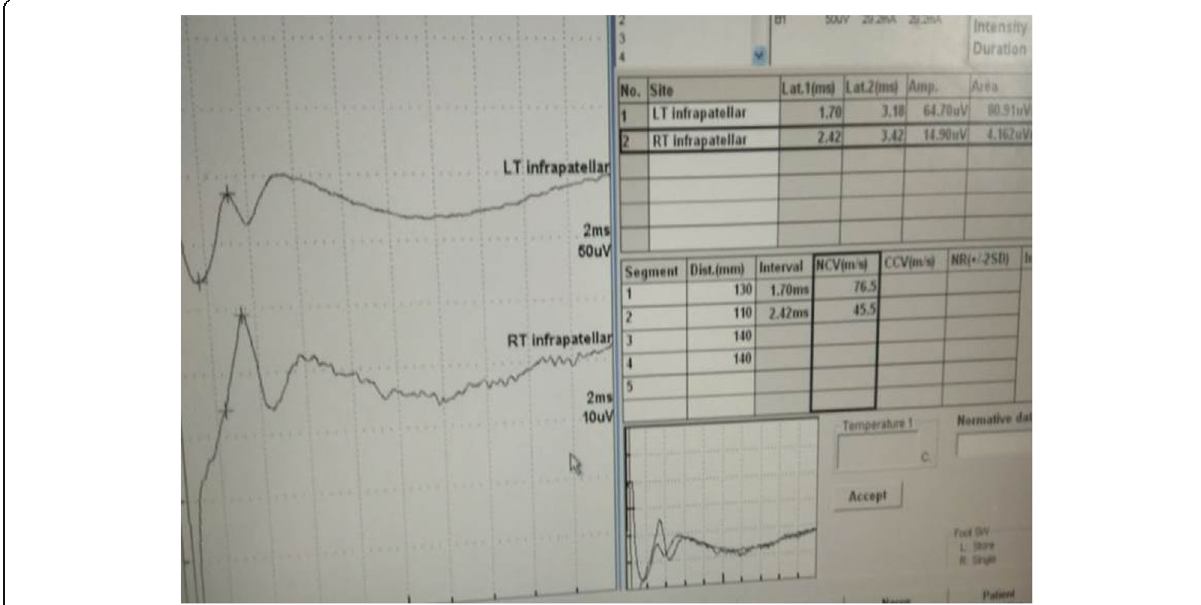
Fig. 2 Electrophysiological parameters of infrapatellar nerve including the peak sensory latency and amplitude, performed in the department of Rheumatology and Rehabilitation by assessment of the sharing rheumatologist using NIHON KOHDEN apparatus